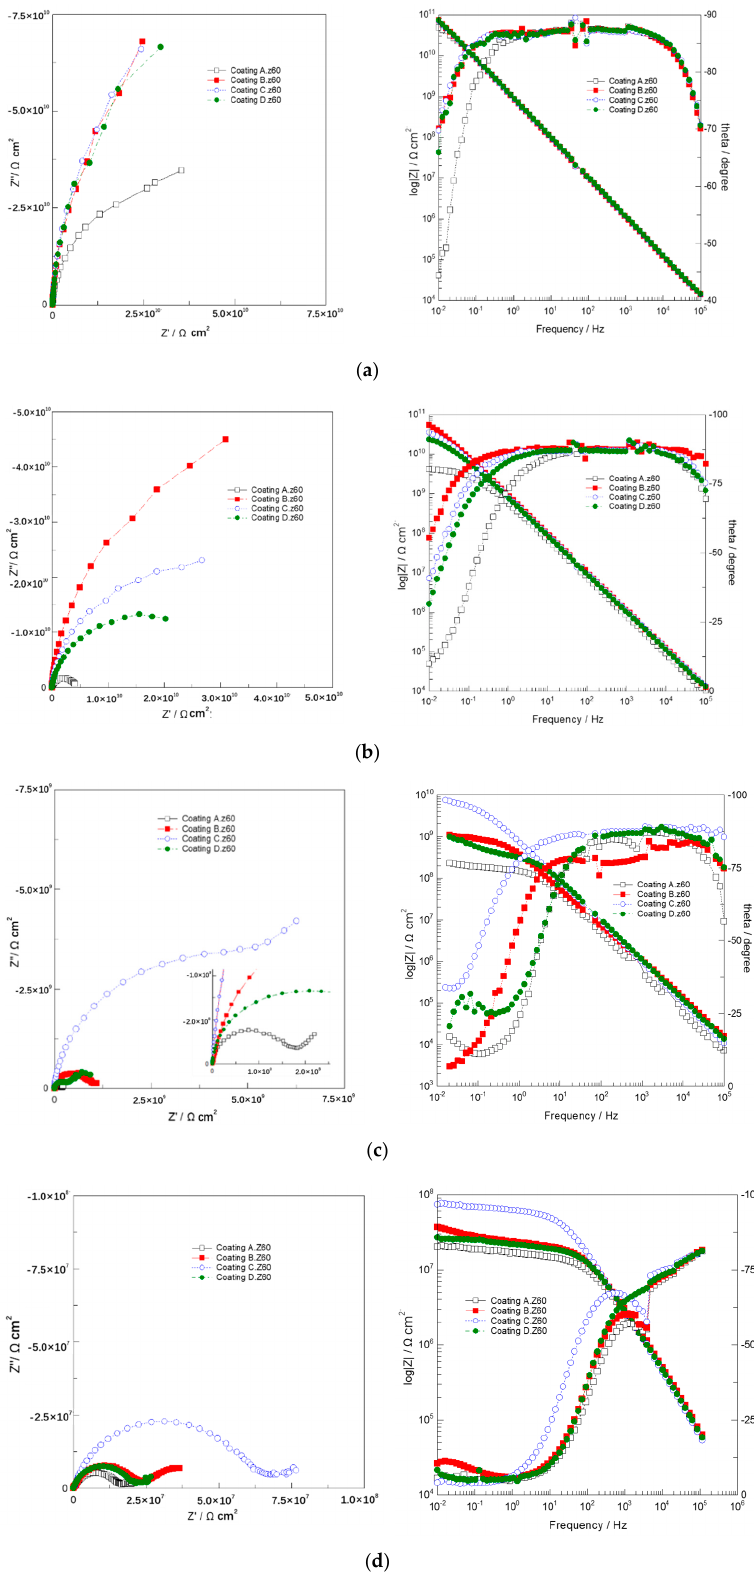
Figure 5. Nyquist and Bode diagrams of EIS measurements of 2024 Al-alloy coated with the coatings containing different ratios of GLYMO immersed in 5 wt.% NaCl solution. ( a ) 0.5 h; ( b ) 150 h; ( c ) 690 h; ( d ) 1050 h.